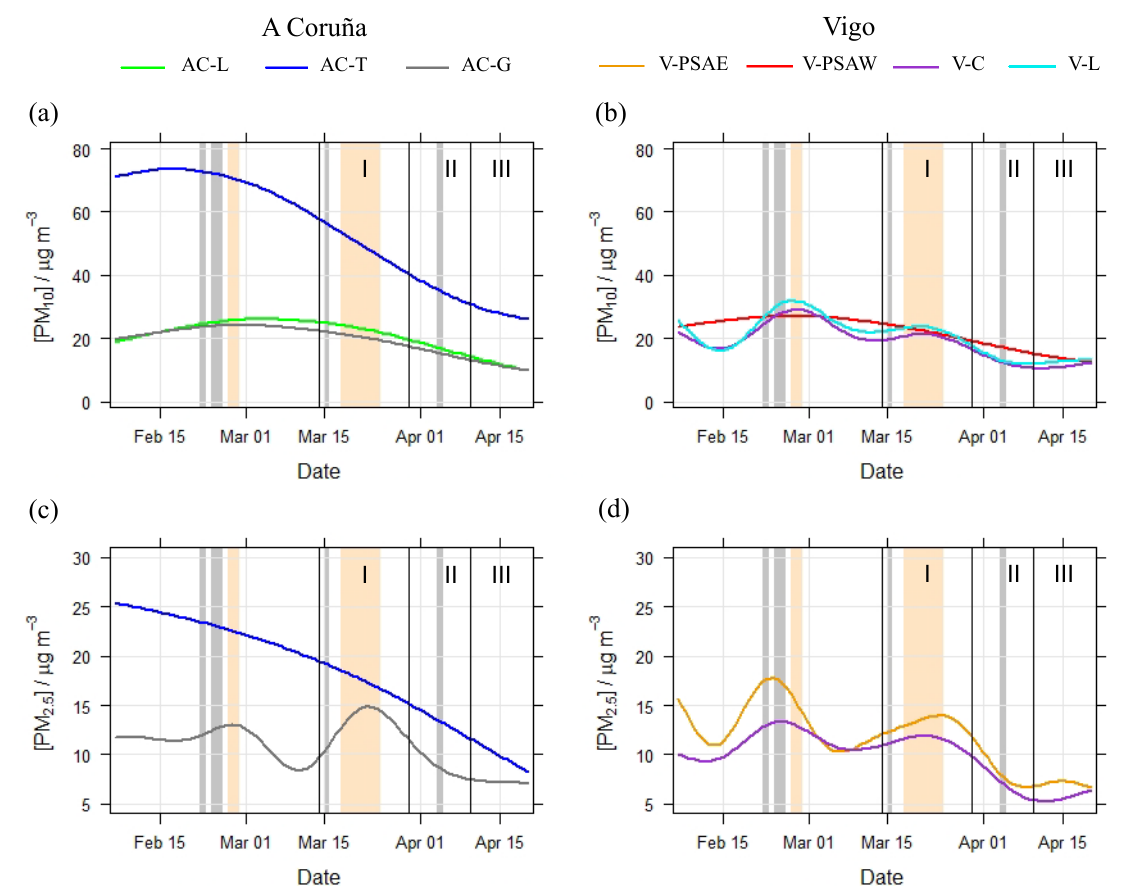
Figure 2. Concentration evolution of PM 10 ( a , b ) and PM 2.5 ( c , d ) (24 h mean) before and during the lockdown period. The left and right panels correspond to data obtained for air quality monitoring stations in the cities of A Coruña and Vigo, respectively. The areas highlighted in gray and yellow show days with biomass combustion and Saharan dust intrusion, respectively. Time periods of lockdown stages (I, II, and III) are also delimited by vertical black lines.